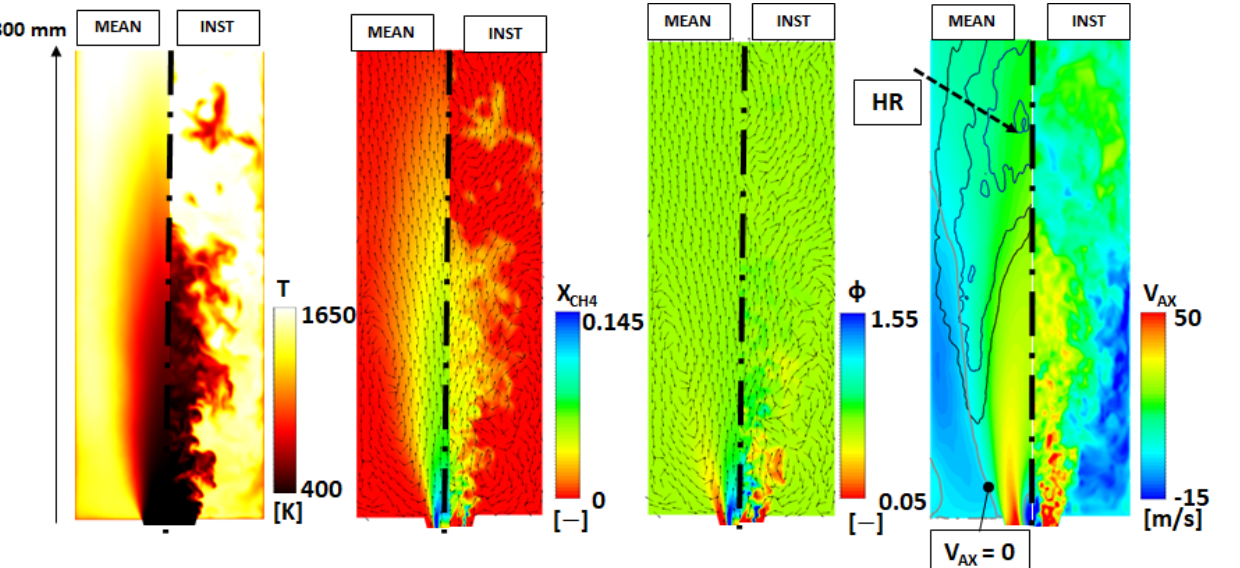
Figure 14. Contours of mean and instantaneous quantities from the TF simulation of (from left to right ) temperature, methane mole fraction X CH , equivalence ratio φ , and axial velocity, with 4 heat-release (HR) isolines superimposed. Normalized vectors of velocity are superimposed on the methane mole fraction and the equivalence ratio